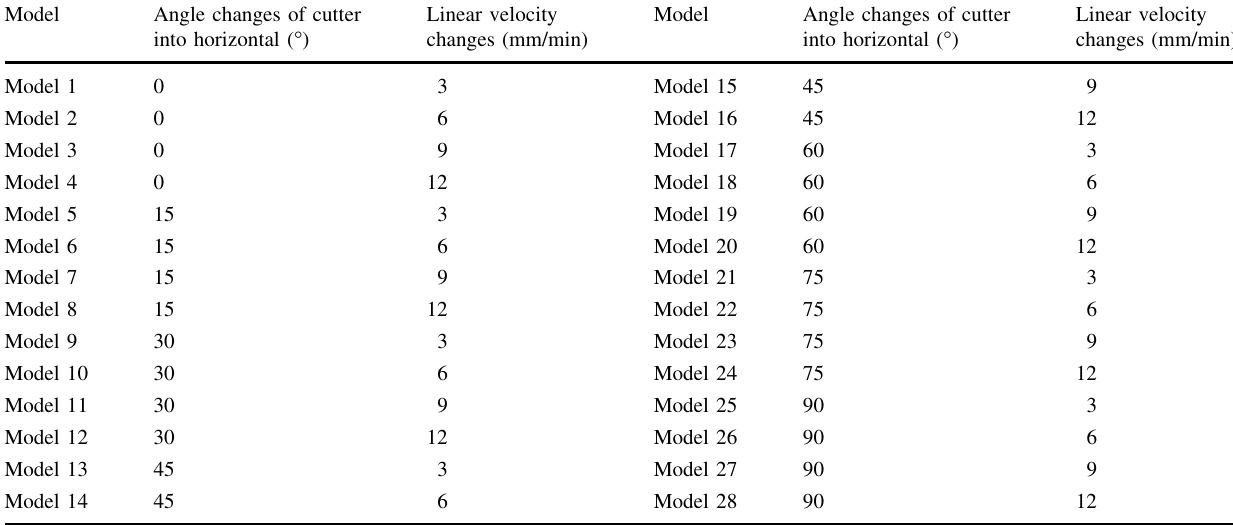
Table 4 Specification of plow